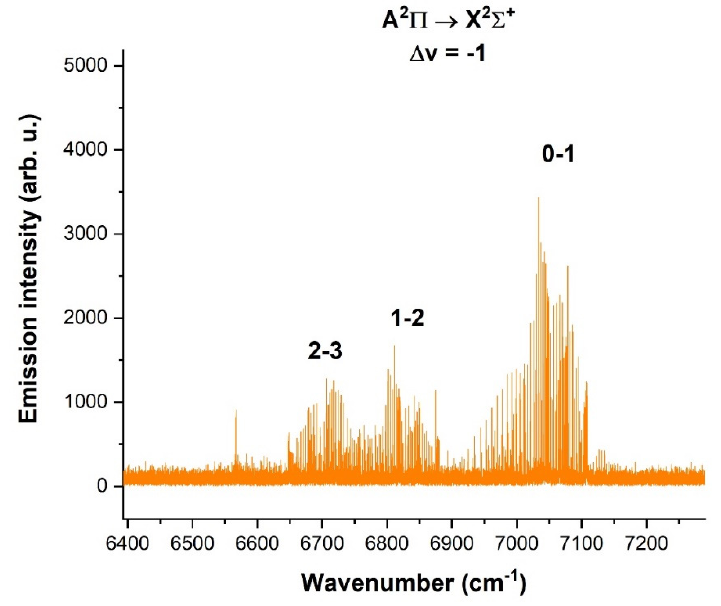
Figure 25. Spectrum of electronic bands of CN radical for the ∆ v = − 1 sequence (24 µ s).